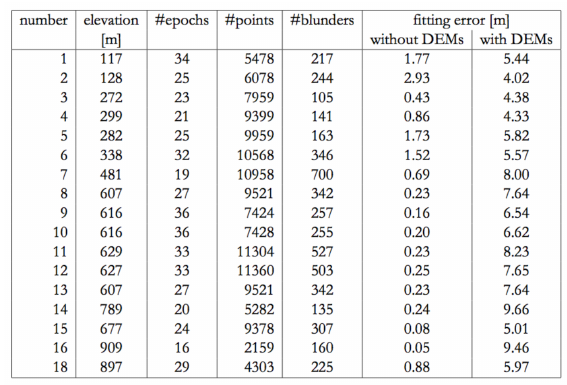
Figure 7. Statistics and errors for the 18 SERAC times series used as control information for the fusion and the correction process. Locations are shown by small yellow circles in Fig. 5.